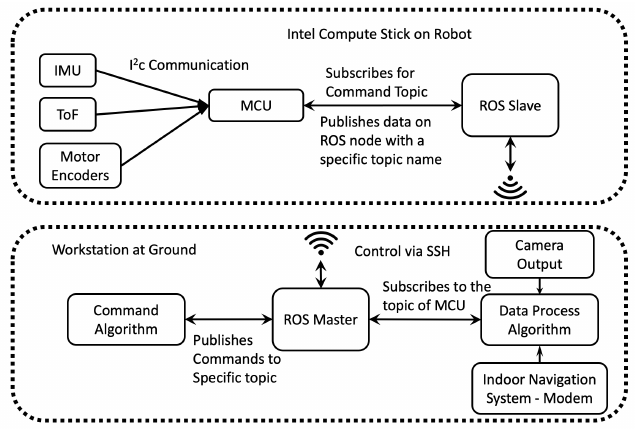
Figure 13. Robot Operating System (ROS)- Mantis sensor integration system.